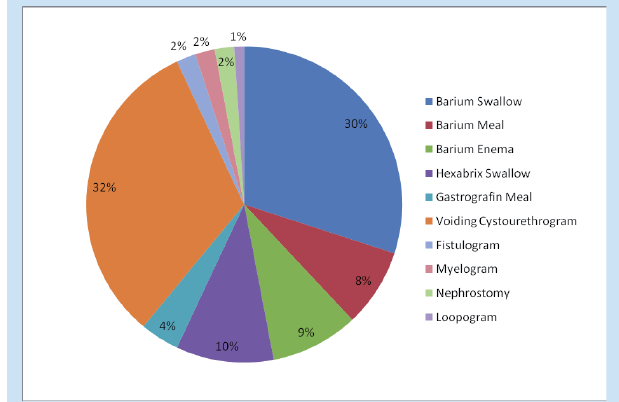
Fig. 1. Pie chart showing the case